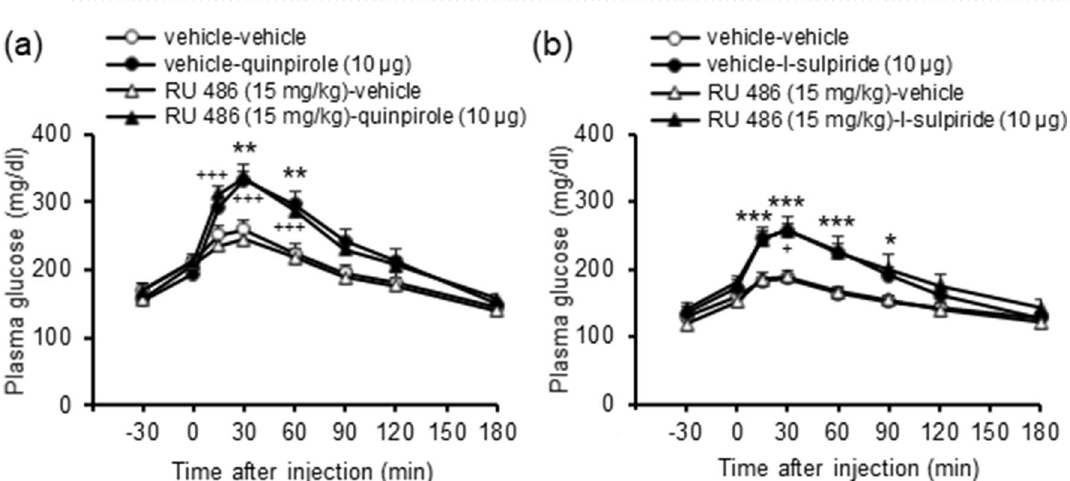
Figure 3. Effect of the glucocorticoid receptor antagonist on hyperglycemia induced by the dopamine D 2 receptor agonist and antagonist. RU 486 (15 mg/kg, i.p.) was administered 30 min before injection of quinpirole (10 μg, i.c.v.; a ) or l-sulpiride (10 μg, i.c.v.; b ). Each point represents the mean ± S.E.M. of 7–9 mice. * P < 0.05, ** P < 0.01, *** P < 0.001 vs. vehicle group. + P < 0.05, +++ P < 0.001 vs. RU 486-vehicle